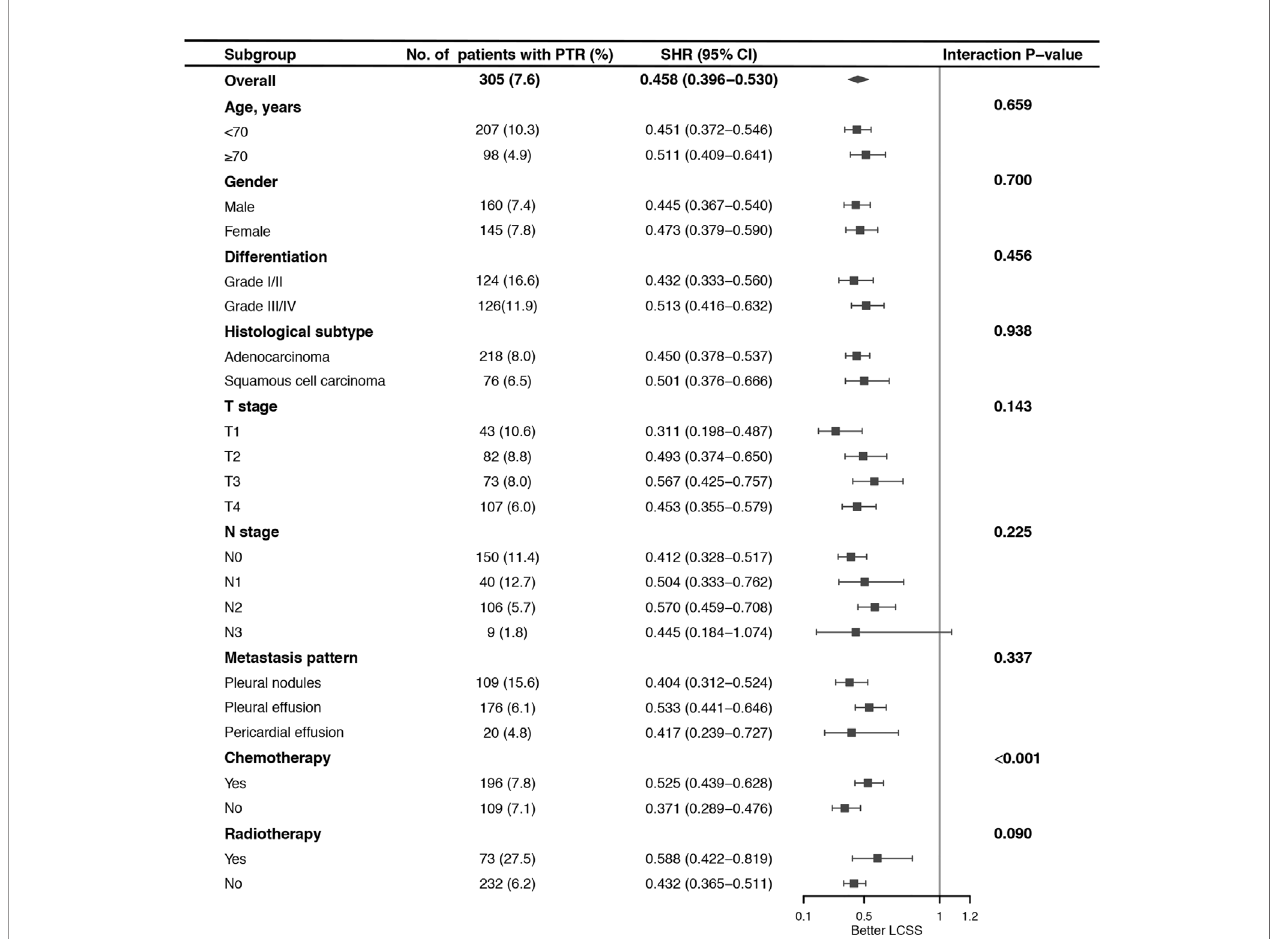
FIGURE 4 | Subgroup analysis of the impact of primary tumor resection (PTR) on lung cancer-speci fi c survival (LCSS) strati fi ed by clinicopathologic